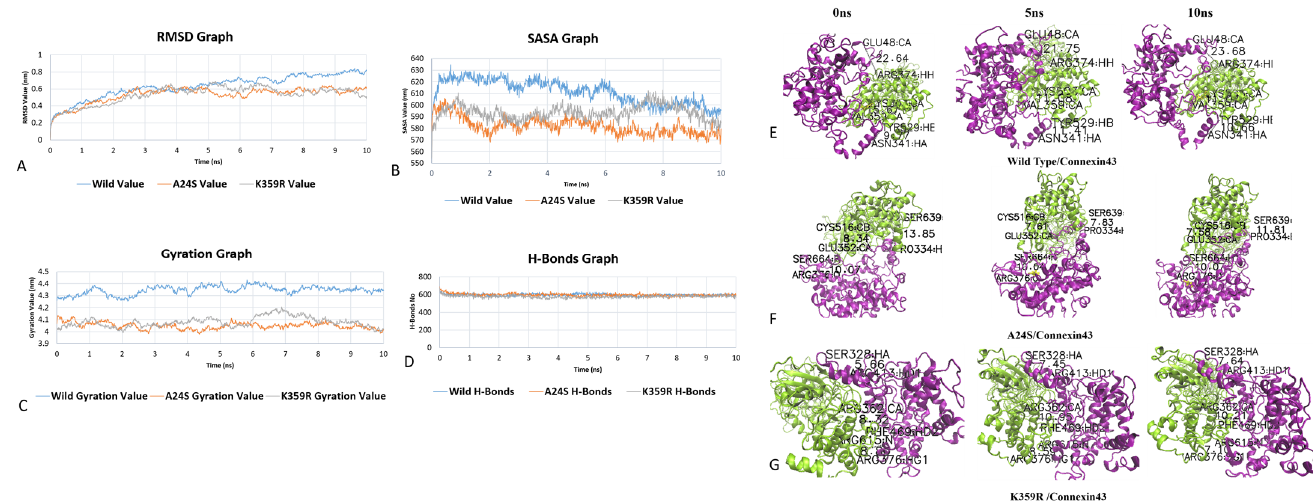
Figure 3. Analysis of simulation trajectory of native (Blue) and mutant structures A24S (Orange) and K359R (Gray) of PKCγ bound to connexin 43: ( A ) Root mean squared deviation (RMSD) plot for each trajectory over each 10 nanosecond production run, wild-type proteins have a higher RMSD value than mutant A24S and K359R. ( B ) The solvent-accessible surface area (SASA) analysis showing the more exposed surface area of wild and buried surface area for both mutants. ( C ) Radius of gyration of PKCγ and bound protein connexin 43 during the simulation run. Wild proteins have larger gyration values showing loose interaction, while both mutant A24S and K359R have smaller gyration values showing strong interaction with connexin 43. ( D ) H-bonds formed over the simulation run. ( E ) Two-dimensional (2D) view of the distance between hydrogen bond interaction of wild PKC γ (Green) with connexin 43 (purple) at different intervals. ( F ) Two-dimensional (2D) view of the distance between hydrogen bond interaction of Variant A24S PKCγ (green) with connexin 43 (purple) at different intervals. ( G ) Two-dimensional (2D) view of the distance between hydrogen bond interaction of variant K359R PKC γ (green) with connexin 43 (purple) at different